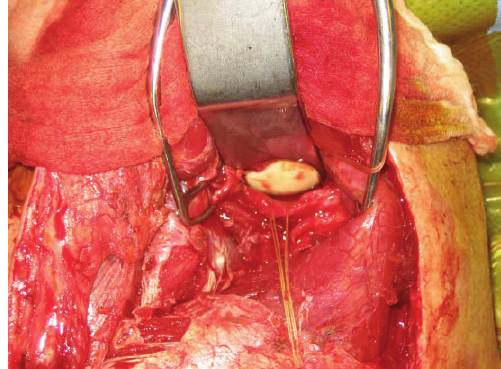
Figure 9: The interval between the infraspinatus and teres minor is developed with meticulous care taken to avoid the axillary nerve and the innervation to the infraspinatus. The scapular fracture is exposed within this